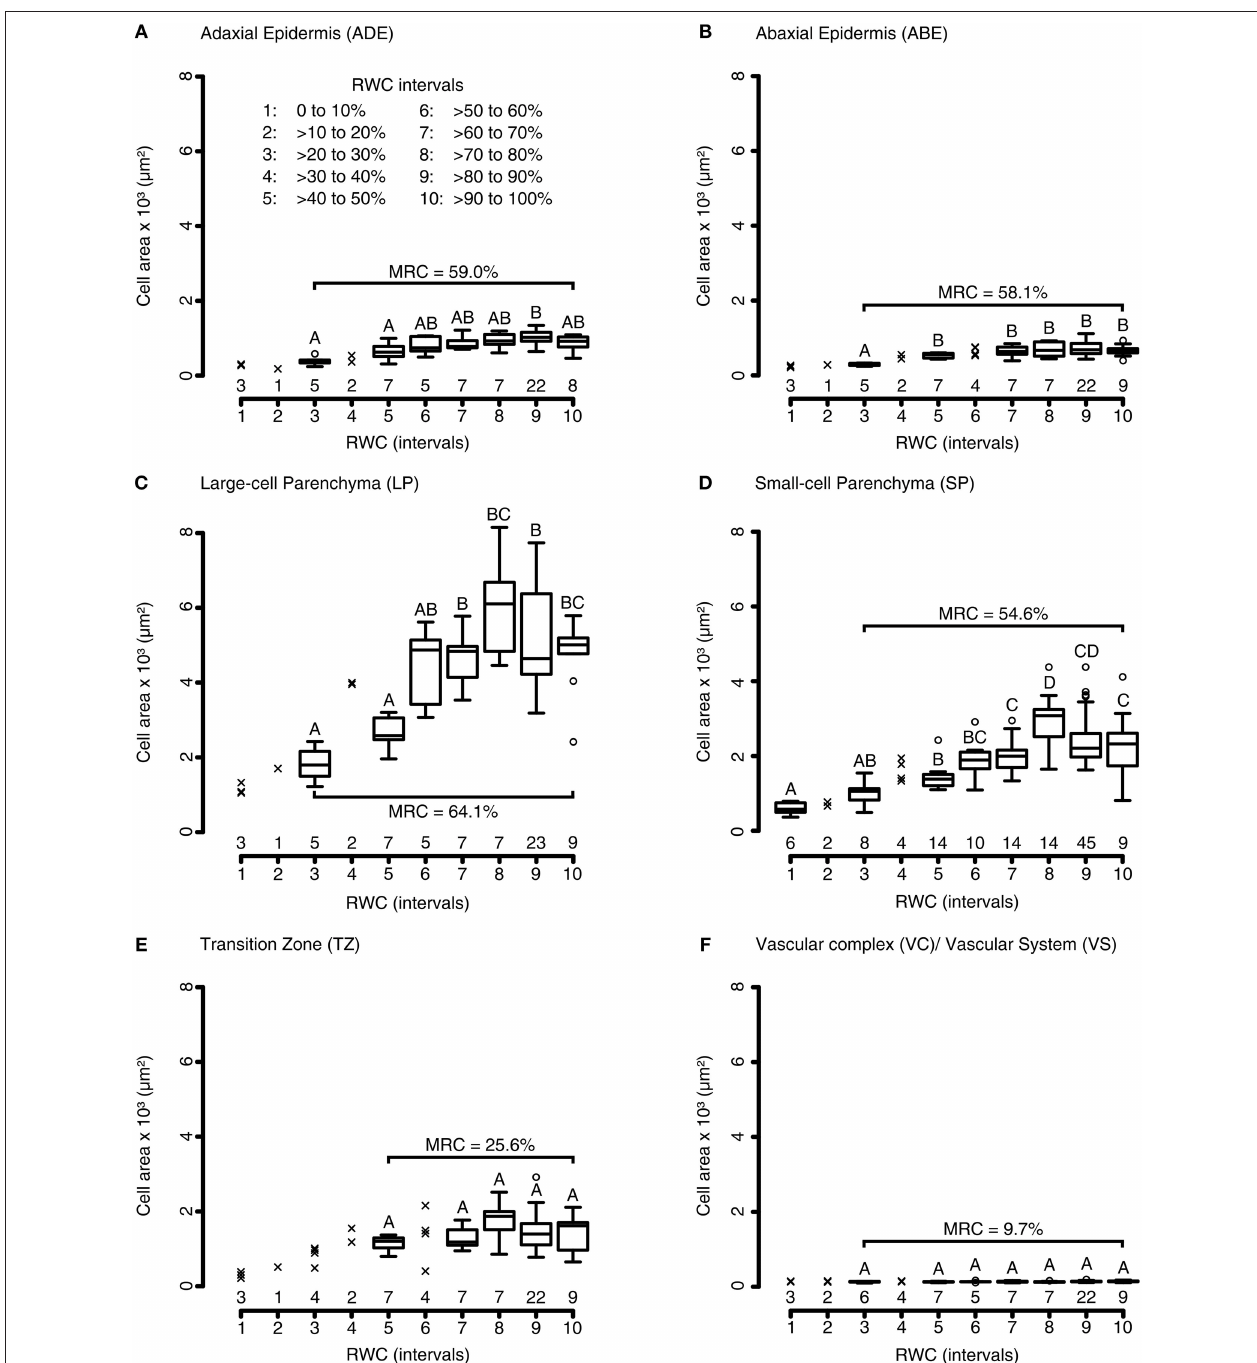
FIGURE 4 | Tissue morphological alterations of R. myconi petioles during DREs. Cell area alterations of the adaxial epidermis (A) , the abaxial epidermis (B) , the large-celled parenchyma (C) , the small-celled parenchyma (D) , the transition zone between vascular and parenchymatous tissues (E), and the vascular system (F) in response to varying RWCs [100 to 0% RWC at 10% intervals, see legend in (A) ]. The group sample sizes (below) and statistical references (above, Kruskal-Wallis test) are given for each boxplot. Outliers are presented as circles, single values as crosses. The median relative cell area changes (parentheses) are calculated from the cell areas at full turgescence (RWC interval 10) and those at the lowest RWC interval with N > 5 (usually interval 3, only for TZ interval 5 was used). ABE, abaxial epidermis; ADE, adaxial epidermis; LP, large-celled parenchyma; MRC, median relative cell area change; SP, small-celled parenchyma; TZ, transition zone between the vascular and the surrounding tissues; VC, vascular complex; VS, vascular